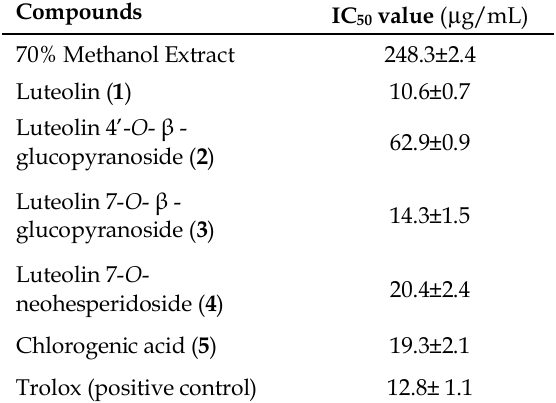
Table 3. IC 50 ( µ g/mL) values of extract and isolated compounds of A. triphylla var. triphylla for DPPH free radical scavenging activity